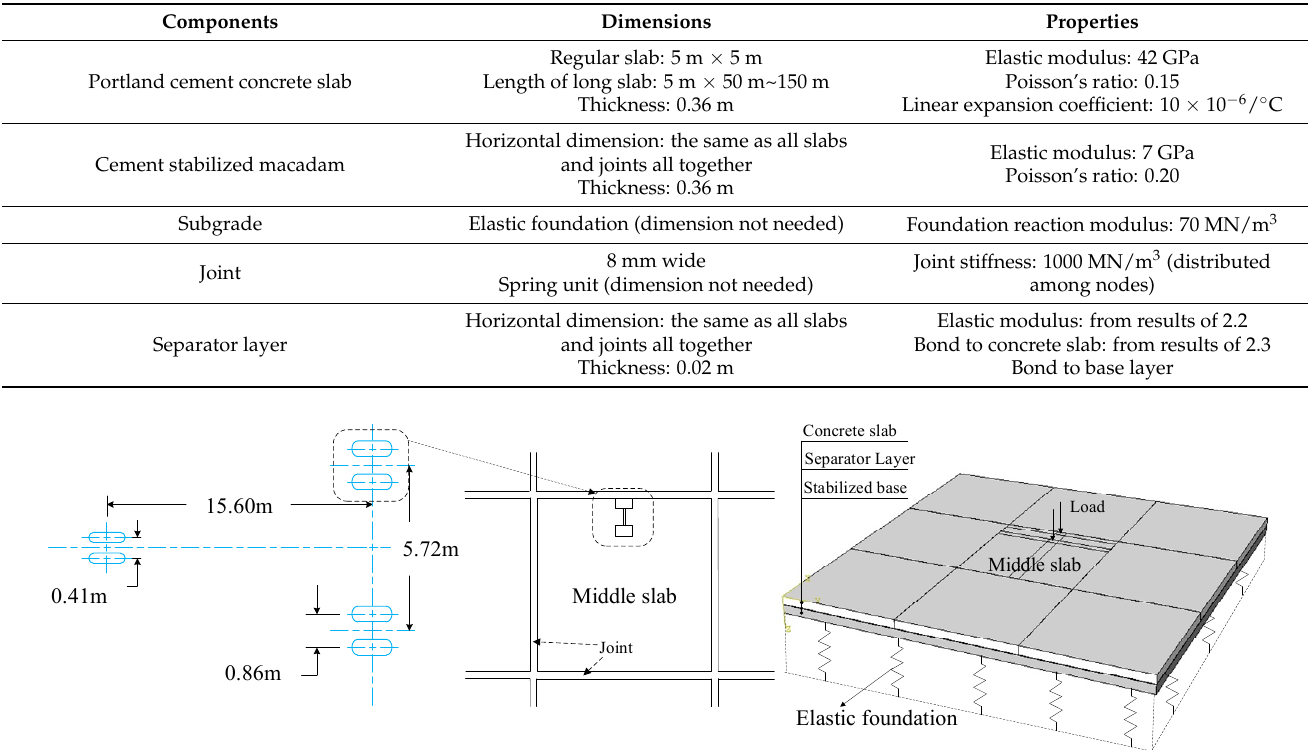
Table 4. FEM structure and material properties for each layer.